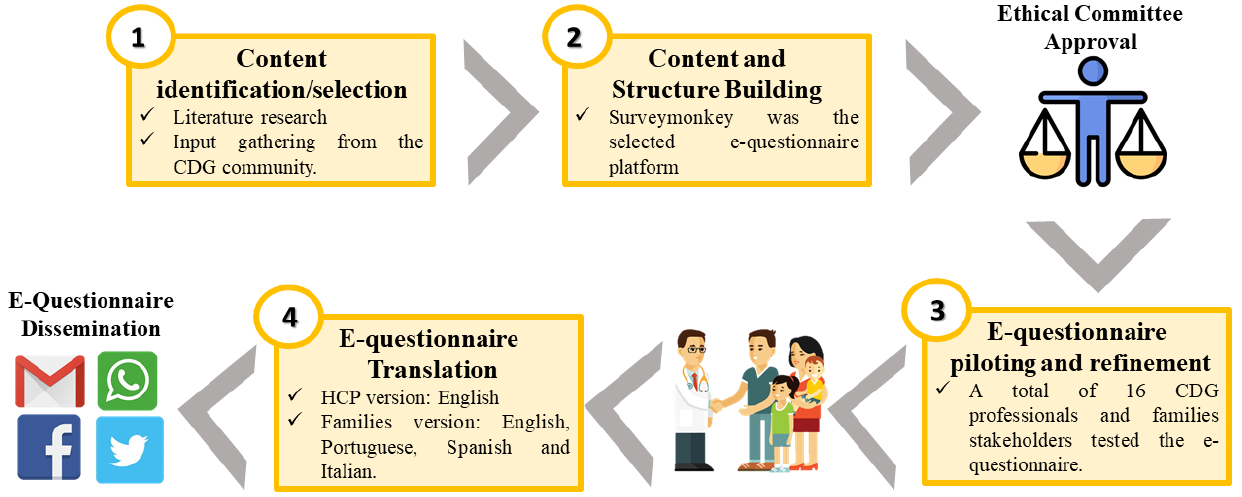
Figure 1. Schematic of the workflow that was used to develop the CDG Journey Mapping Questionnaire.